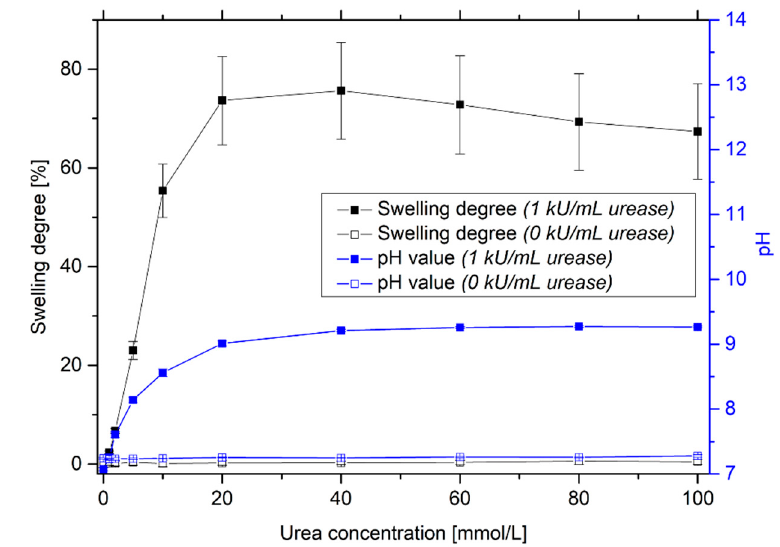
Figure 3. Swelling behavior of enzyme-functionalized and non-functionalized poly(AAc- co -DMAEMA) hydrogels and resulting pH value for different urea concentrations.